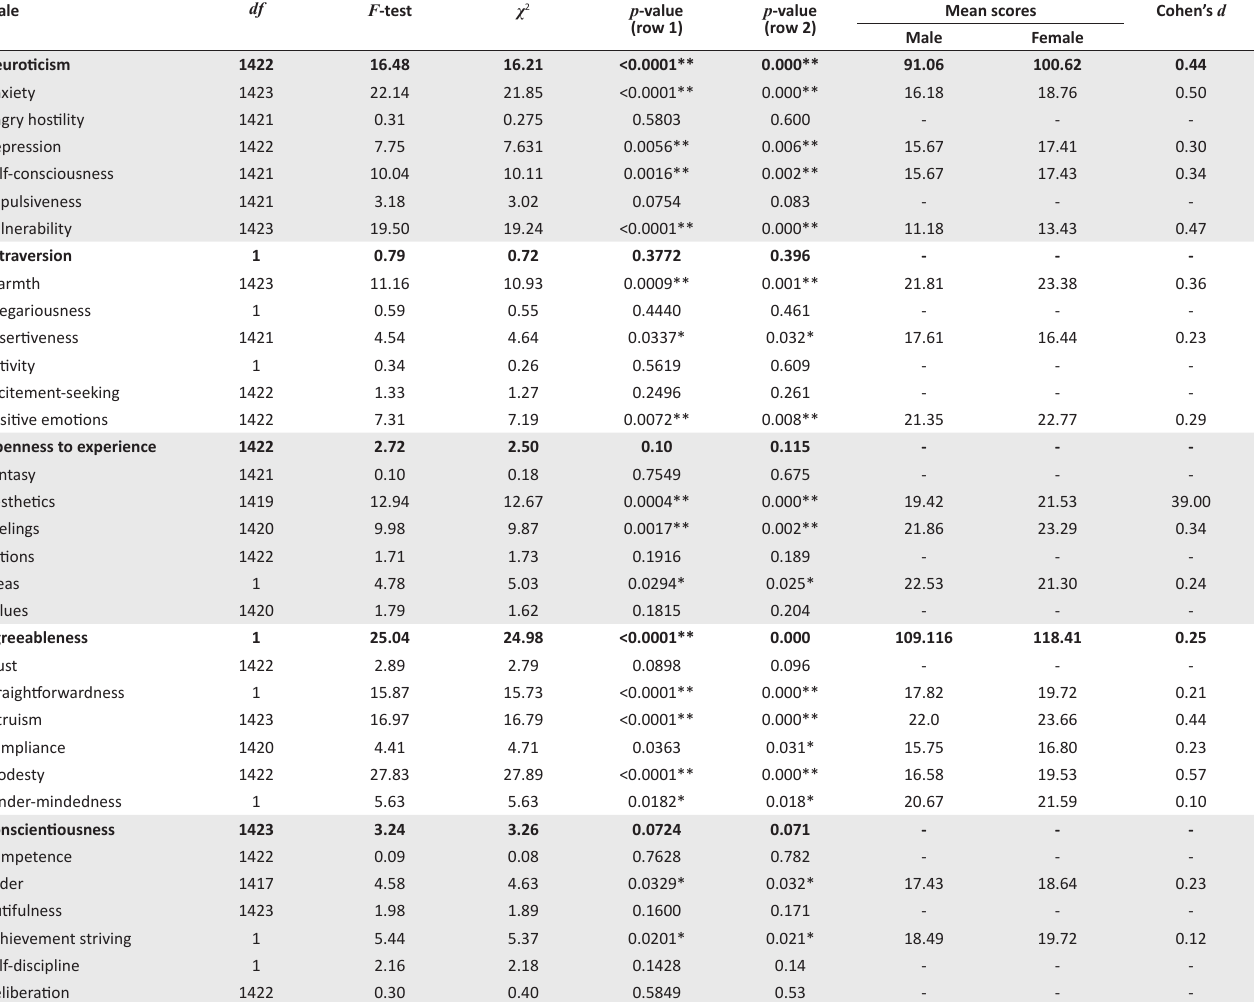
TABLE 2: ANOVA results for gender on the NEO-PI-R (row 1) and ANCOVA results after partialling out the effects of race on the NEO-PI-R (row 2). Scale